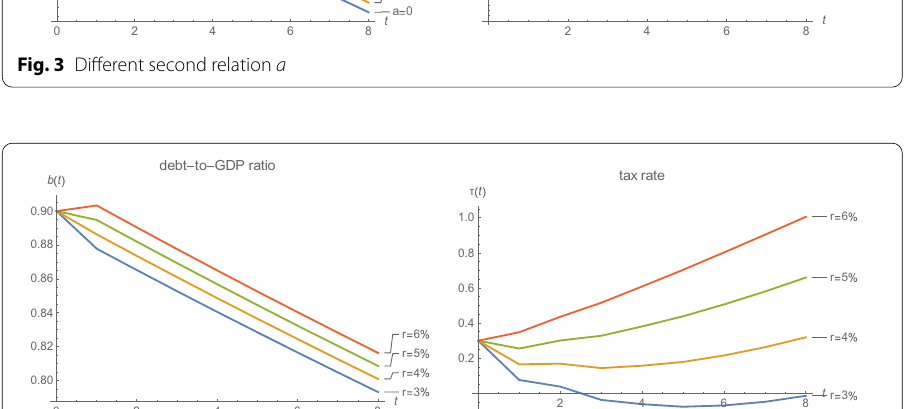
Fig. 3 Different second relation a